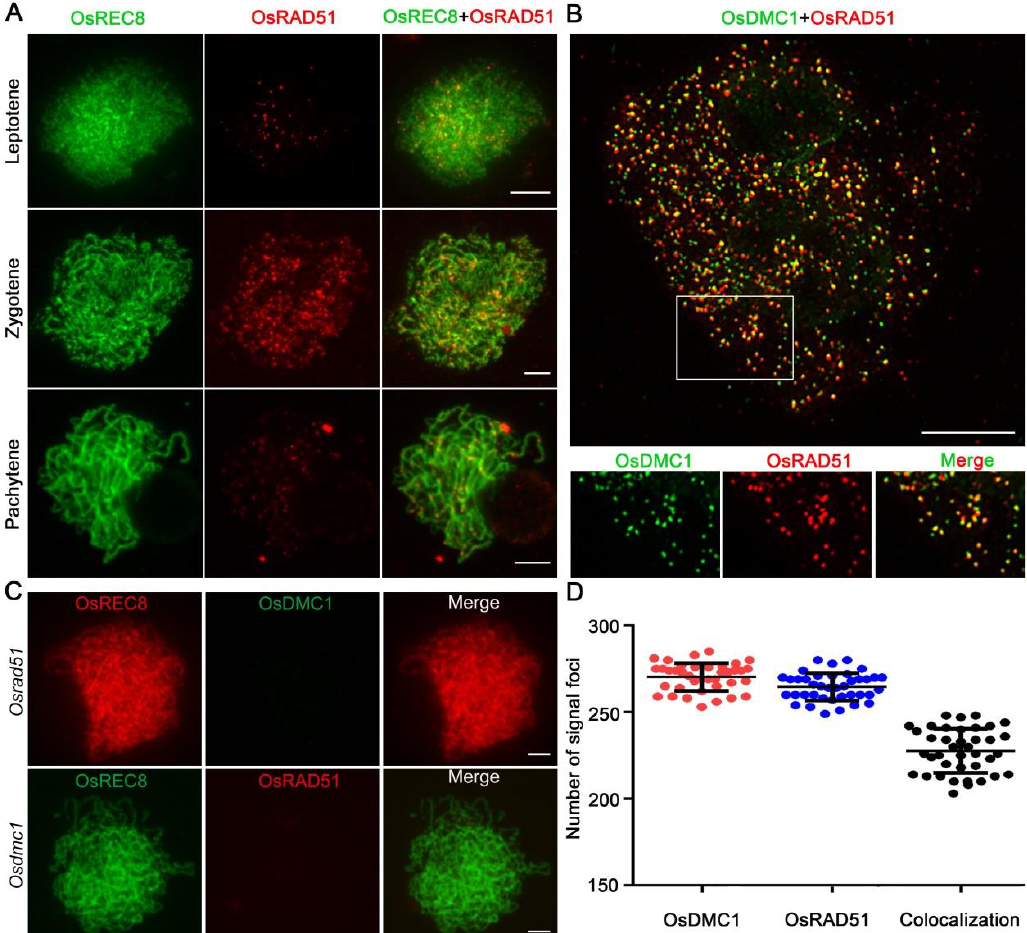
Figure 5. OsRAD51 can co-localize with OsDMC1. ( A ). Immunolocalization of REC8 (green) and OsRAD51 (red) in wild-type PMCs from leptotene to pachytene. Bars, 5 µ m. ( B ). Immunostaining of OsDMC1 (green, from mouse) and RAD51 (red, from rabbit) in wild-type PMCs at pachytene. The OsRAD51 signals were co-localized with the OsDMC1 signals, exhibiting bright yellow signal points. Magnified images of the boxed region are shown in the panels below. Bars, 5 μm. ( C ). The OsRAD51 signal cannot be detected in Osdmc1 , and the OsDMC1 signal cannot be detected in Osrad51 . Bar, 5 μm. ( D ). Quantification of the co-localized signal foci of OsDMC1 and OsRAD51 per PMC in the wild type (n = 39).